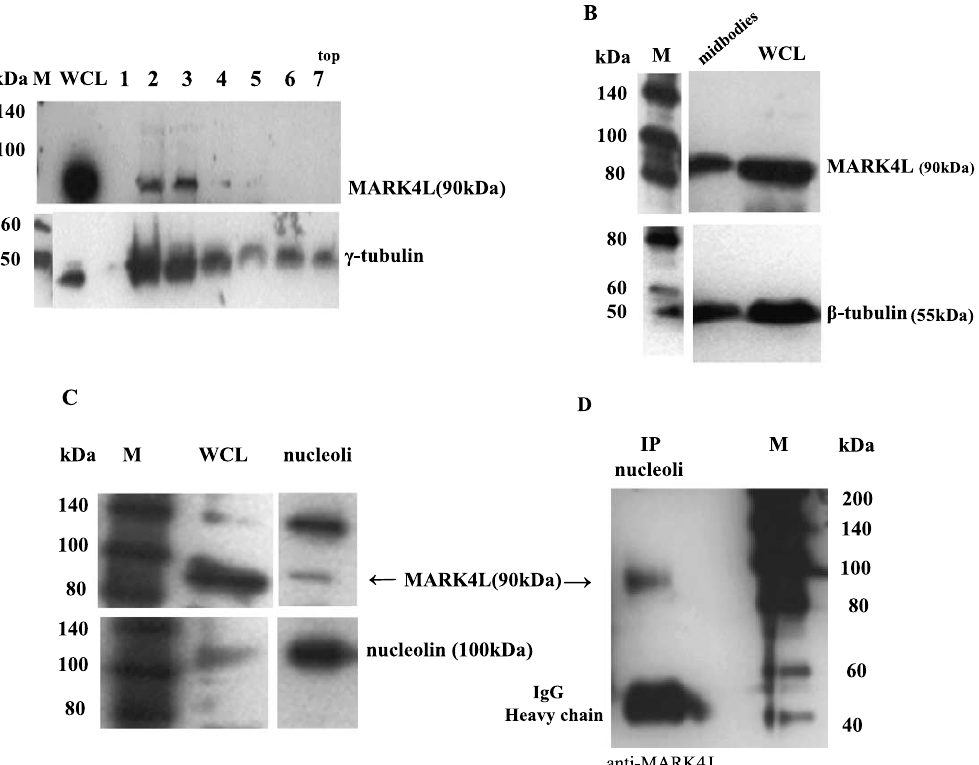
Fig. 4. (A) Immunoblot analysis of whole cell lysate (WCL) and centrosome fractions (1–7) from the MI-4 cell line. Upper panel: immunos- taining with anti-MARK4L antibody; lower panel: immunostaining with anti- γ -tubulin antibody. (B) Immunoblot analysis of midbodies and whole cell lysates from the MI-60 cell line. Upper panel: immunostaining with anti-MARK4L antibody; lower panel: immunostaining with anti- β -tubulin antibody. (C) Immunoblot analysis of whole cell lysate and nucleoli from the MI-60 cell line. Upper panel: immunostaining with anti-MARK4L antibody; lower panel: immunostaining with anti-nucleolin antibody. (D) Nucleoli fraction immunoprecipitated and immunos- tained with anti-MARK4L antibody. M: molecular weight ladders